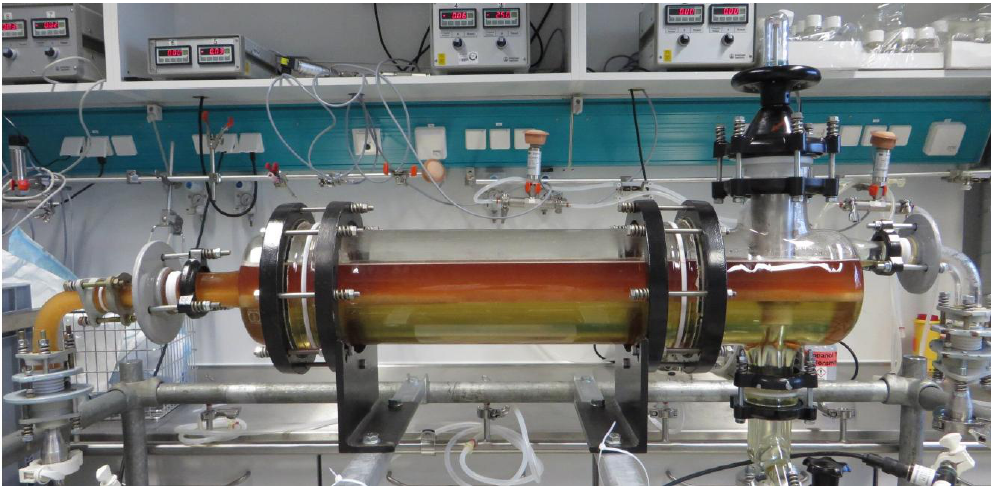
Figure 15. Side view of the pilot-scale settler (DN150, 12.6 L hold-up) during continuous settling operation (900 s residence time). Table 5. Comparison of batch and continuous ATPE of 160 L system volume. The pressure increase refers to 117 L/m² area-specific filtration volumes.